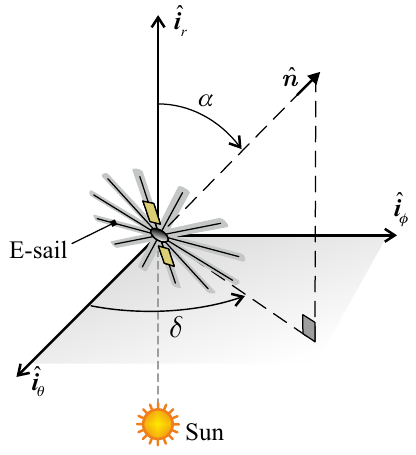
Figure 4. E-sail control angles { α , δ }